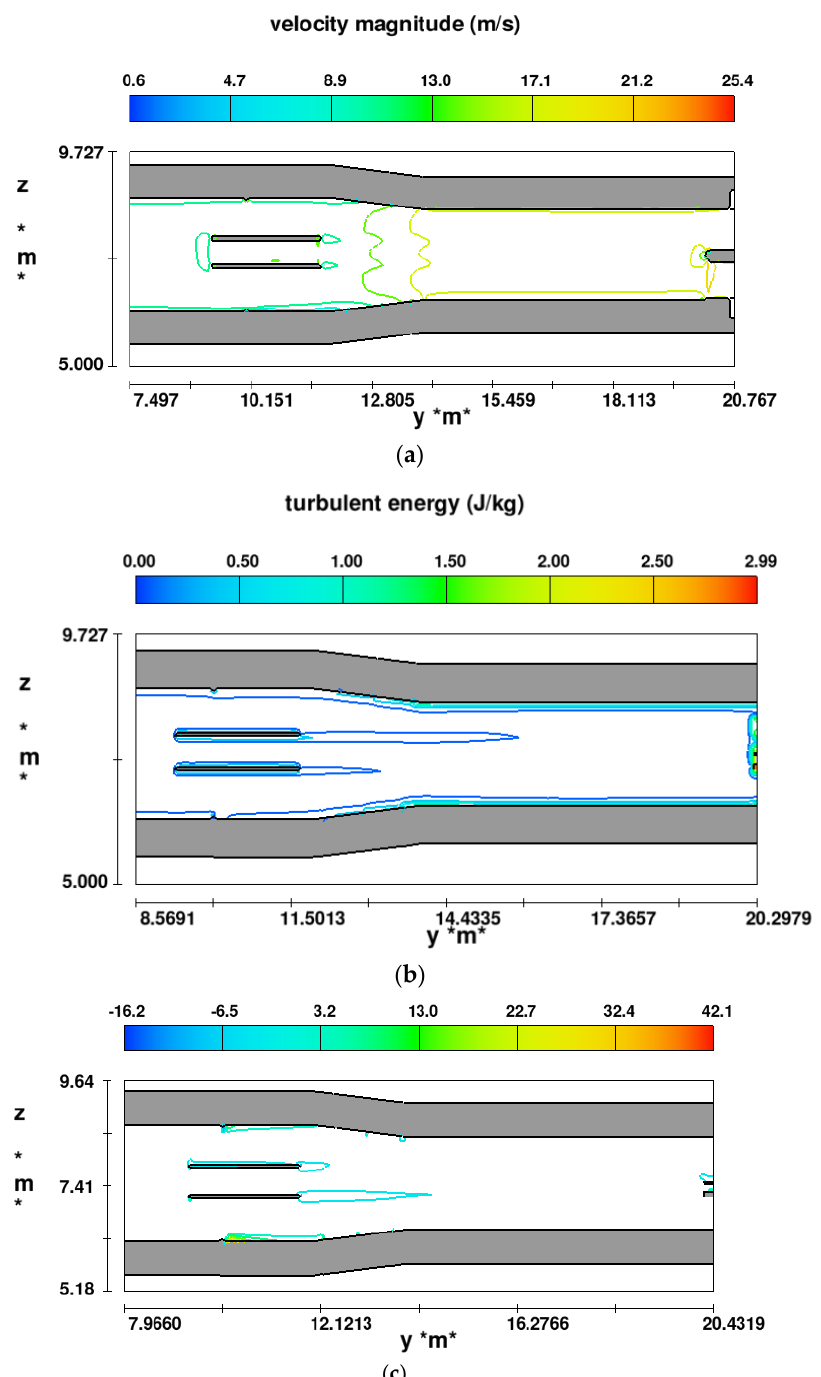
Figure 12. ( a ) The Sectional view of velocity magnitude contours for the longitudinal distance between two valves = 5D; ( b ) The Sectional view of turbulent energy contours for the longitudinal distance between two valves = 5D; and ( c ) Vorticity contours.